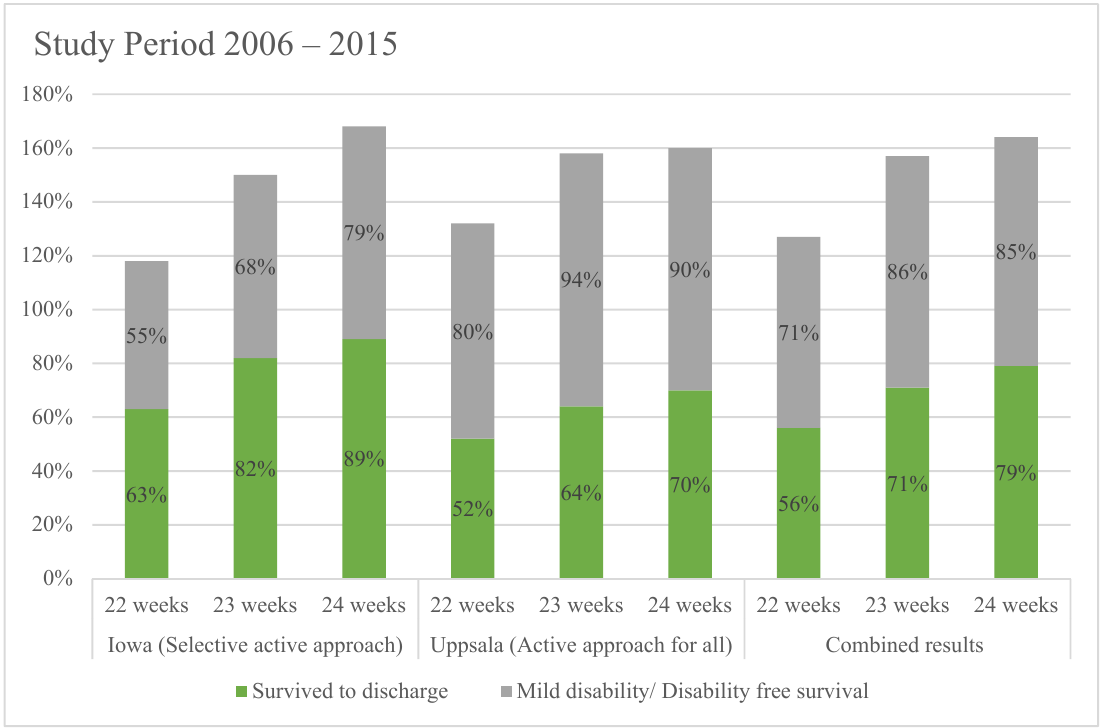
Figure 2. Comparative perspective for outcome at the margins of viability